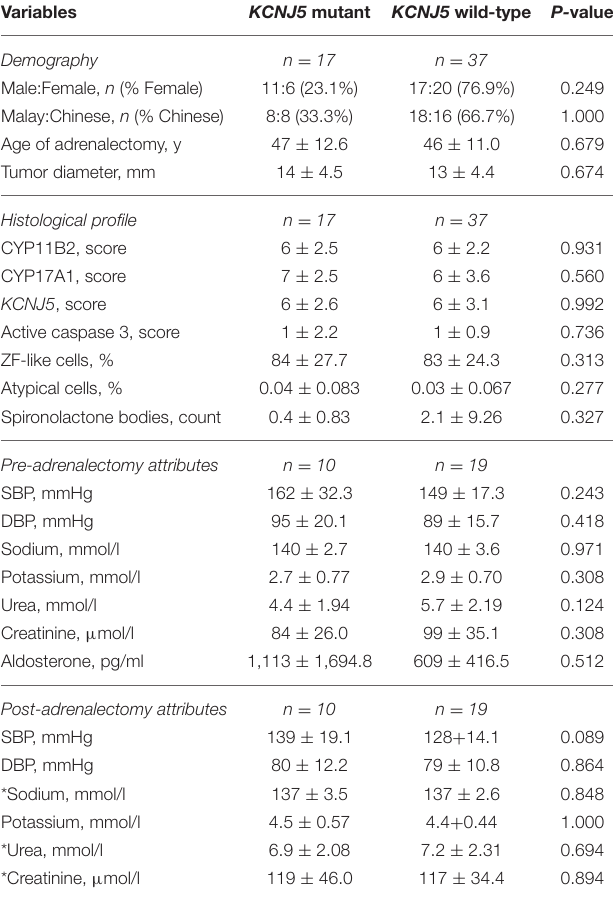
TABLE 1 | Characterization of Malaysian cohort by the APA KCNJ5 mutant status. Variables